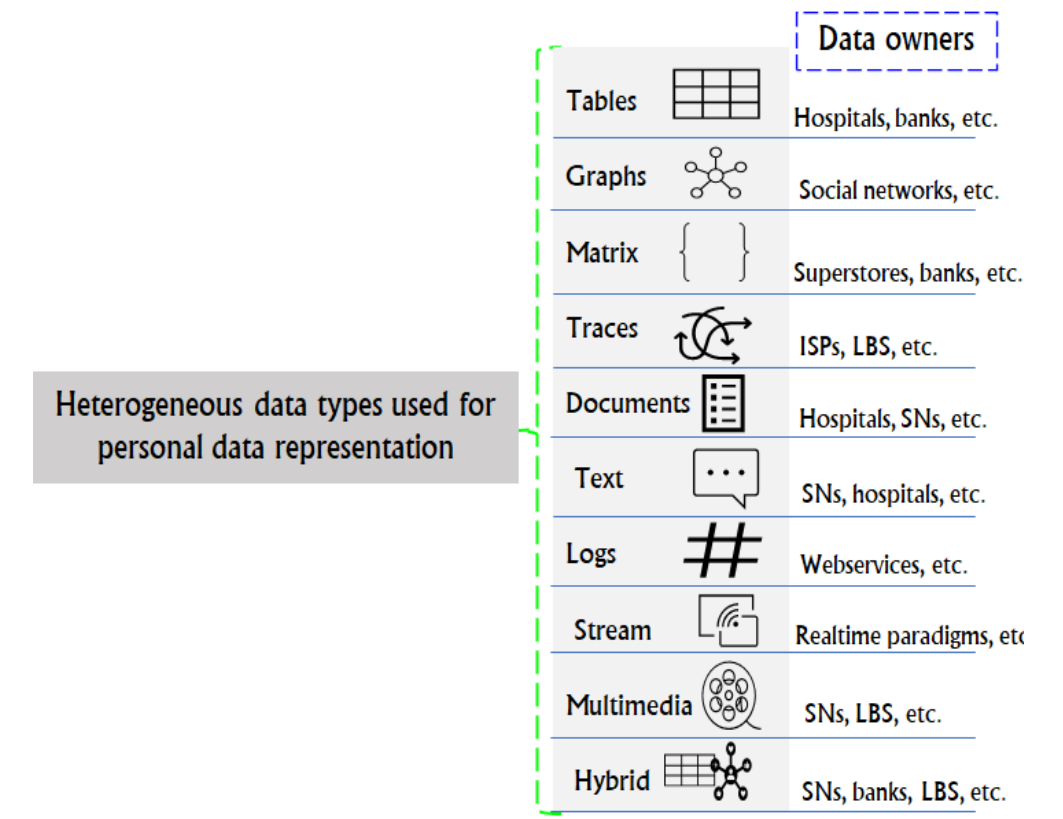
Figure 3. Overview of the heterogeneous data types used to represent personal data.